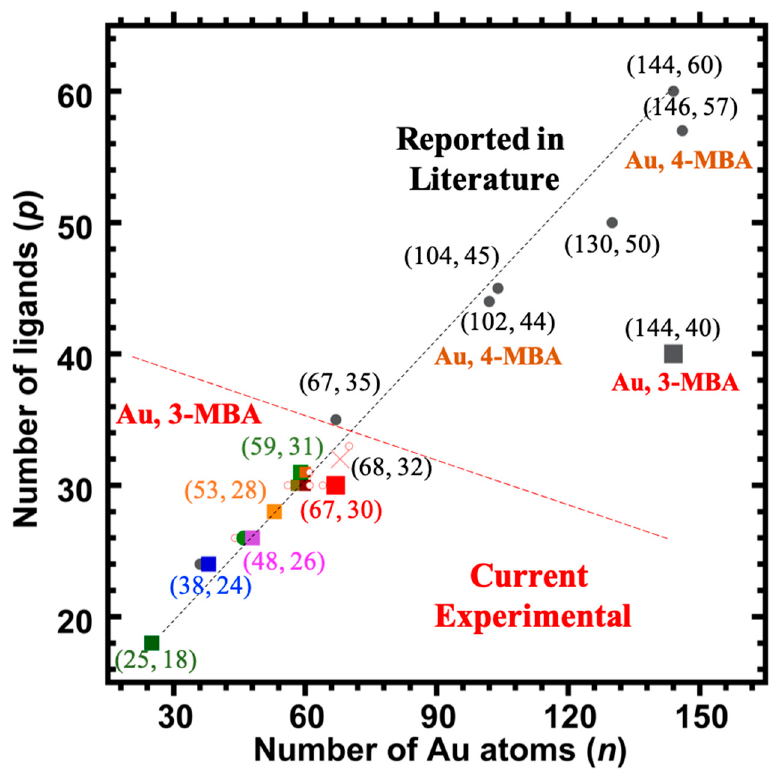
Figure 6. The number of ligands ( p ) vs. the number of Au atoms ( n ) found in this work on the Au n (3-MBA) p , ( n = 48–67 , p = 26–30) and reported in the literature are shown to see the trends. Legend: symbols designate whether the component identified was detected prominently (colored large square) and for both samples under all ESI-coupled LC/MS conditions, or not (small hollow red circle); a red cross represents the expected (68, 32) clusters, a grey large square represents 3-MBA thiolated larger (144, 40) clusters, whereas small grey circles (filled) represent reported different compositions of other thiolated clusters, for example 4-MBA (a sister molecule of 3-MBA) thiolated Au 146 (4-MBA) 57 .